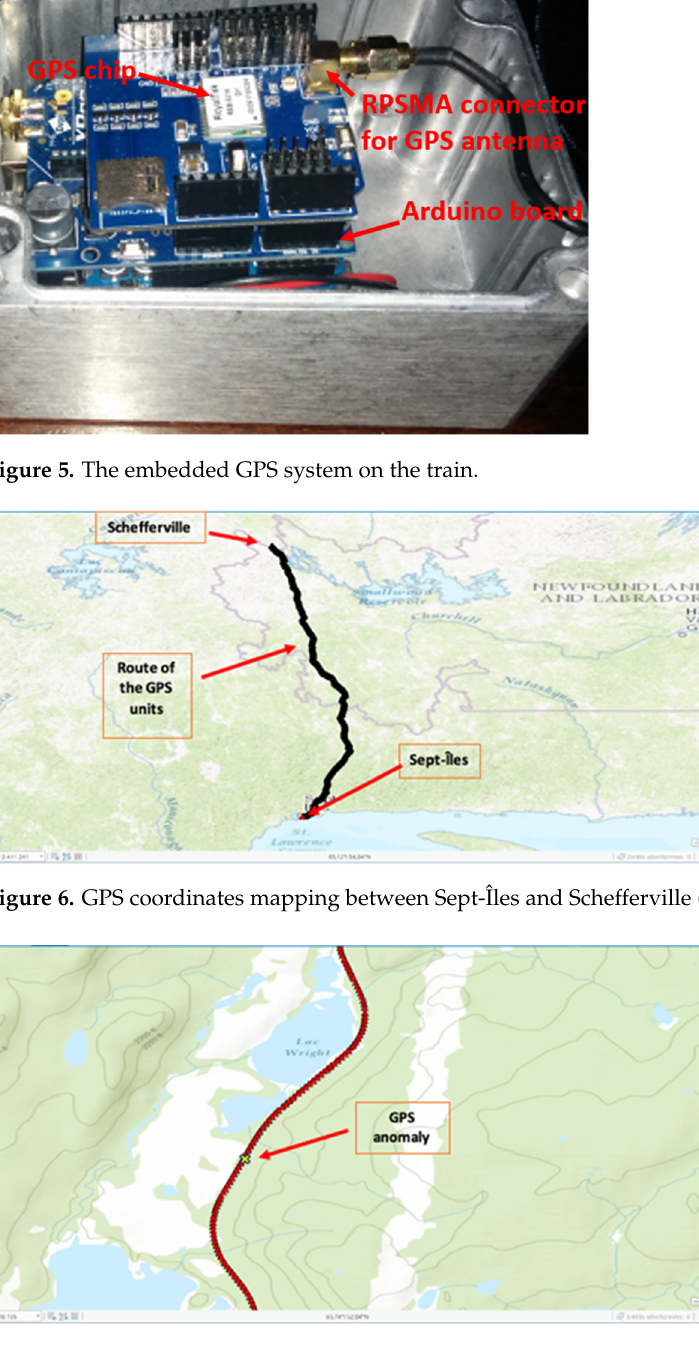
Figure 7. An 86 m distance GPS anomaly toward Mounts Wright.